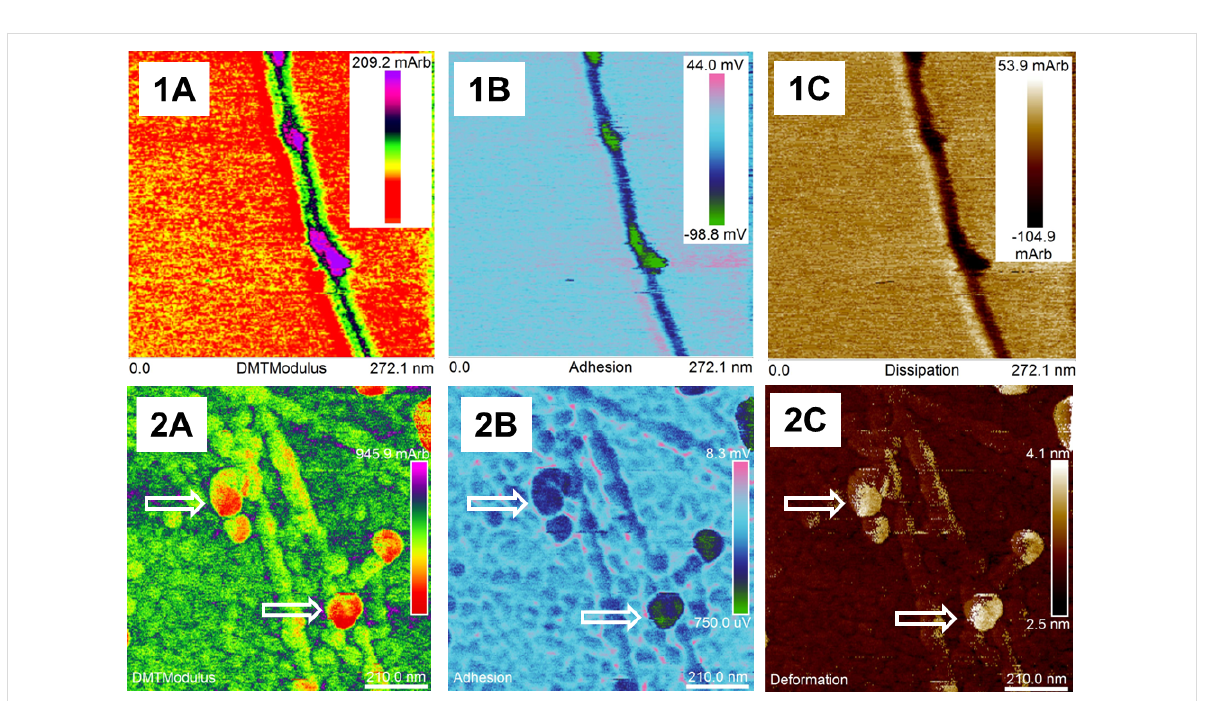
Figure 11: AFM analyses of sodium cholate dispersed SWNTs (1) and SWNT–CR complexes (2); maps of mechanical parameters: (1A; 2A) elas- ticity (Young modulus), red – the lowest value; (1B; 2B) adhesion (green – lowest value); (1C) dissipation (dark – the lowest value); (2C) deformation (white – the highest value). Arrows point to local thickening and decreased stiffness (high plasticity) on the surface of the CR-covered